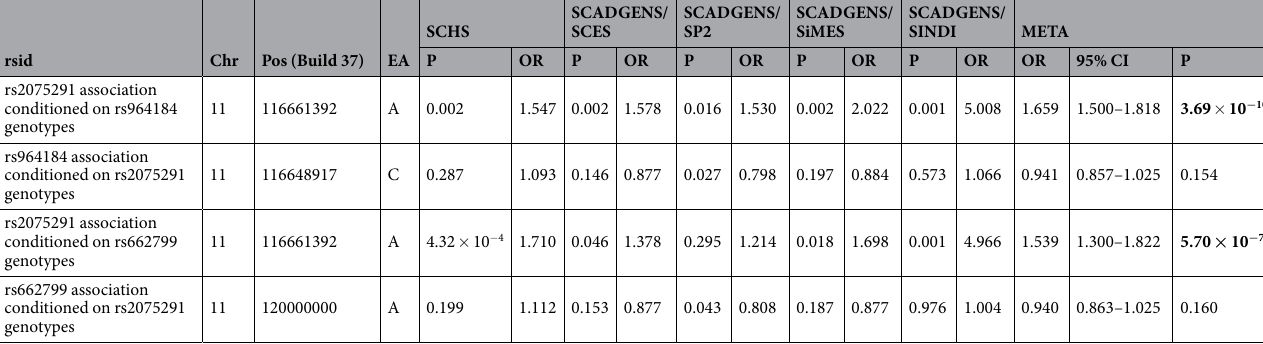
Production in Macrophages”, “Production of Nitric Oxide and Reactive Oxygen Species in Macrophages) and “Glioma Signaling” ( P -value 1.10 × 10 − 5 –0.019, Supplementary Table VI and Supplementary Figure III). These multiple pathways involve the genes APOE, APOA4, APOC4, LPL, APOC1, APOA5, PDGFD, CDKN2A and CDKN2B . In FUMAgwas analysis, the most significant pathways were lipid transport, metabolism and diges- tion mobilization, which involve APOA5, APOE and LPL ( P -value 1.10 × 10 − 5 –5.00 × 10 − 4 , Supplementary Figure IV). DEPICT gene set enrichment included multiple functional classes relevant to lipid metabolism, ie, sphingolipid metabolism, glycosphingolipid metabolism, positive regulation of steroid metabolic process and glycosphingolipid biosynthesis. In addition, there were multiple gene sets associated with abnormal blood vessel function, including regulation of blood vessel size, vascular process in circulatory system and increased vasodi- lation (Supplementary Table VII). We further evaluated associations of regional SNPs in LD (r 2 > 0.2 in 1000 G ASN populations) with the pre- viously reported index SNPs that did not significantly replicate in our datasets. At one locus, rs12202017 ( TCF21 gene), we identified a regional SNP with a significant association in the Chinese, Malay and Asian Indian data- sets (rs9375986, adjusted meta P = 0.019, Supplementary Table VIII and Supplementary Figure V). We further detected stronger and nominal associations ( Meta P: 1.55 × 10 − 3 –4.99 × 10 − 2 ) at 14 additional loci for regional SNPs that were in at least moderate LD (r 2 > 0.2 in 1000 G ASN populations) with previously reported index SNPs